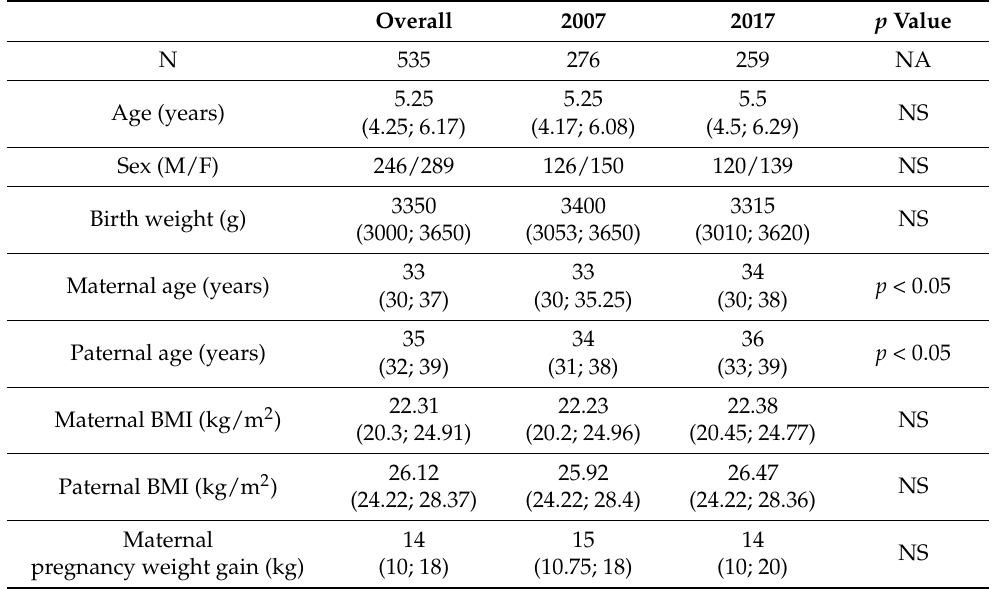
Table 3. Factors associated with excessive weight, overall and by